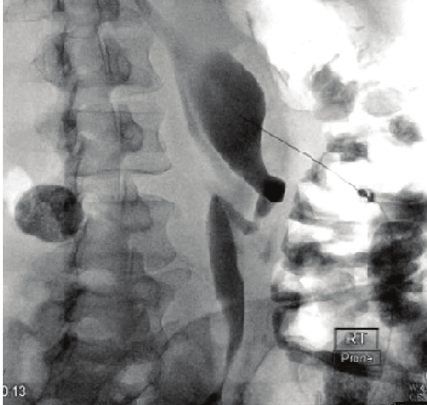
Figure 2: Percutaneous nephrogram illustrating dilated and tortu- ous ureter.